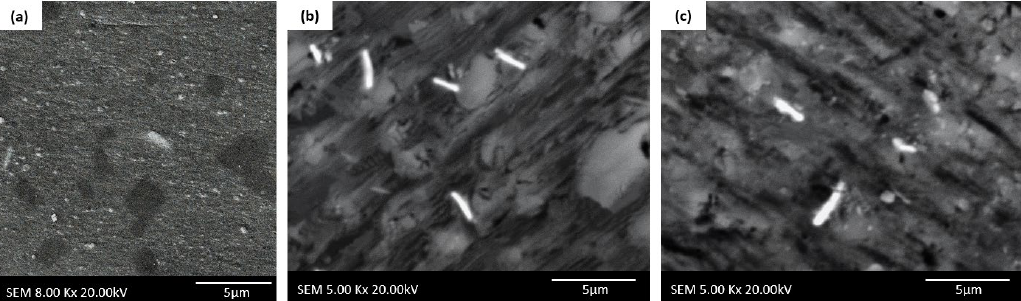
Figure 7. Electron micrographs of specimens ST at ( a ) 540 °C for 6 h and AA at ( b ) 140 °C for 12 h ( c ) 160 °C for 8 h. ( c ) 160 ◦ C for 8 h.